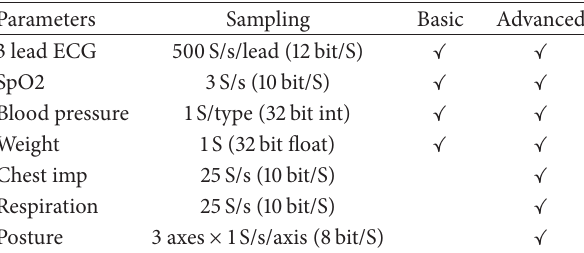
Table 1: Home gateway sensor